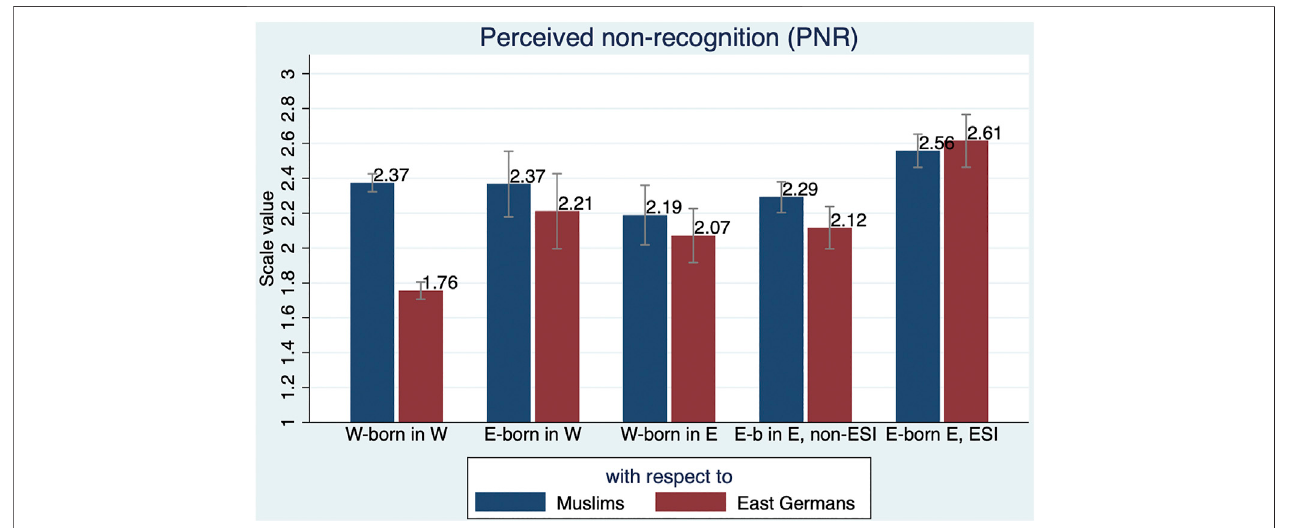
FIGURE 2 | Comparison of perceived non-recognition (PNR) related to Muslims and East-Germans between East-West types.